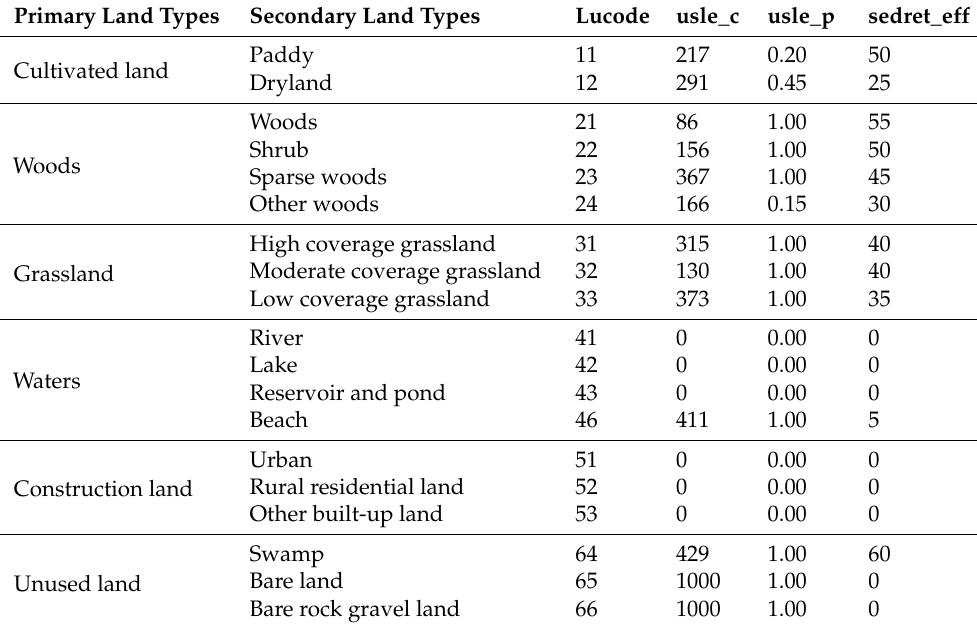
Table 2. Parameters of soil conservation evaluation